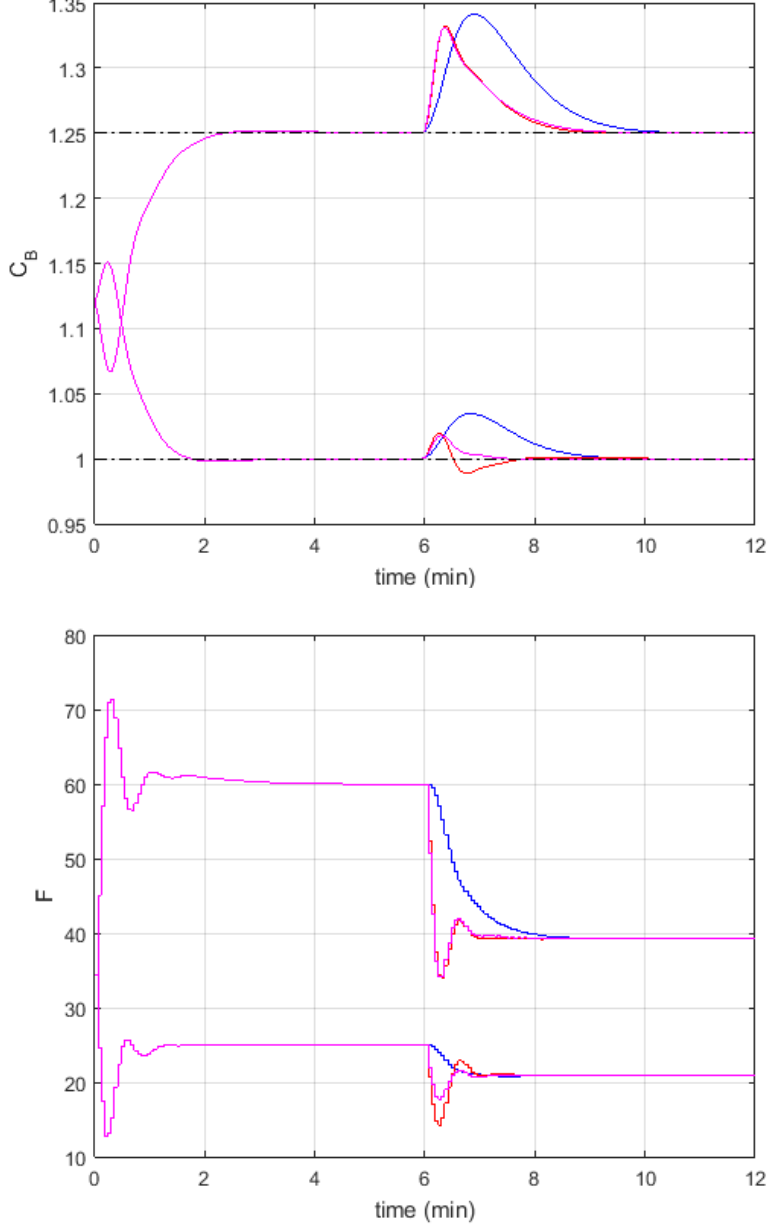
Figure 8. Responses of the control system with FMPC2 algorithm and λ = 0.0001 to changes in the setpoint to C B 1 = 1 mol/L and C B 2 = 1.25 mol/L and to the change of the disturbance by 10% in